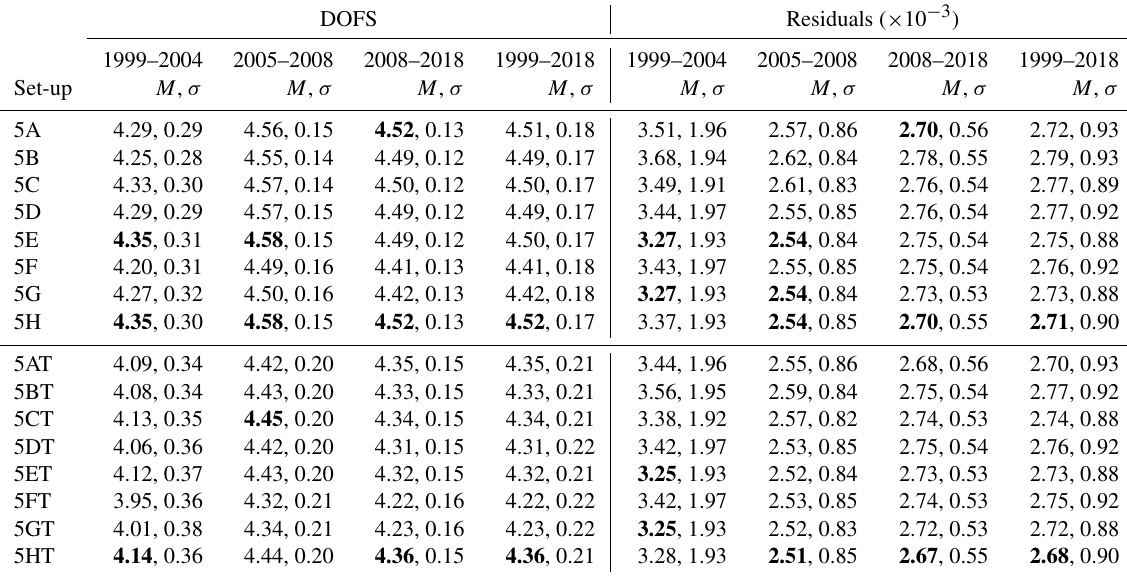
Table 2. Summary of statistics of the DOFS and fitting residuals for the set-ups 5A and 5AT, 5B and 5BT, 5C and 5CT, 5D and 5DT, 5E and 5ET, 5F and 5FT, 5G and 5GT, and 5H and 5HT for the periods 1999–2004, 2005–May 2008, and June 2008–2018 and for the entire time series (1999–2018). The fitting residuals are computed as the signal-to-noise ratio for a common spectral region contained in all set-ups (1001.47–1003.04cm − 1 ). Shown are the median ( M ) and standard deviation ( σ ) for each period. The number of quality-filtered measurements is 466, 683, and 3775 for the three periods, respectively, and 4924 for the whole dataset. The strategies showing the best performance (largest DOFS and smallest residuals) are highlighted in bold for each period.